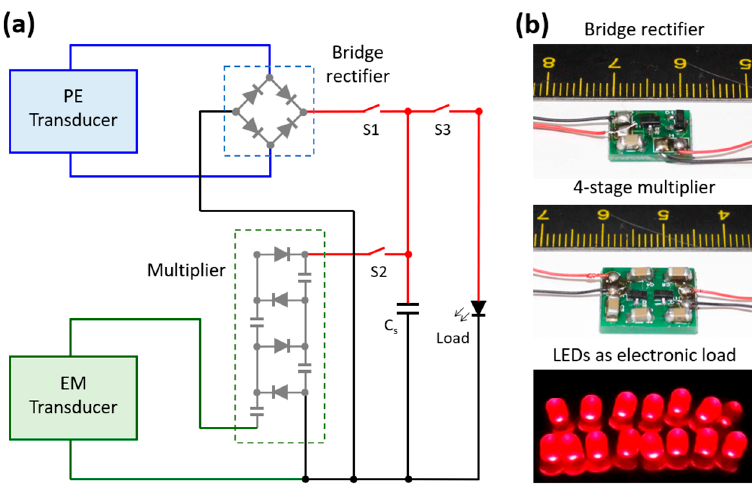
Figure 9. Schematic of the hybrid energy harvester circuit diagram ( a ), photographs of a bridge rectifier, 4-stage voltage multiplier as the AC–DC converters and LEDs powered by the harvester as electronic load ( b ).